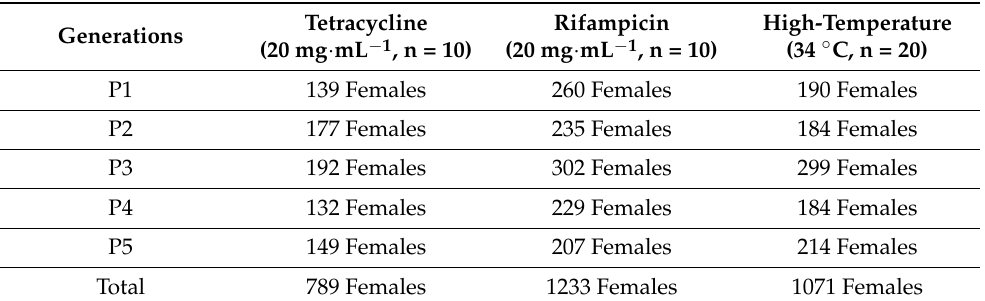
Table 3. The offspring of 5 generations (P1 – P5) produced by thelytokous Diglyphus wani under high temperature and antibiotics.